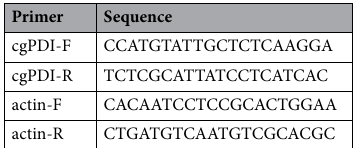
Table 1. Sequences of primers used for cDNA